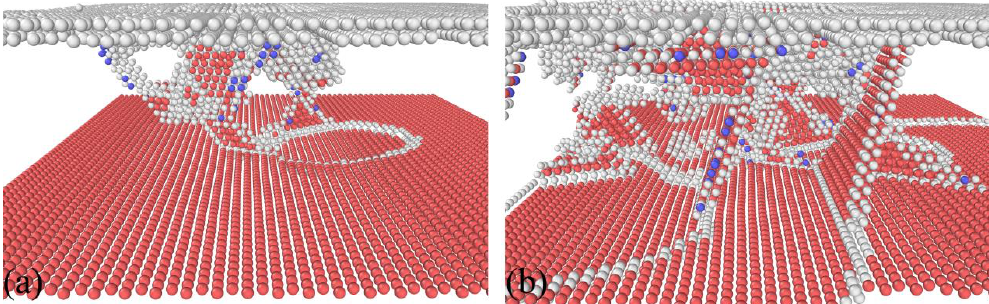
Figure 4. Representative dislocation–TB interactions. Displacement: ( a ) 0.88 nm; ( b ) 1.6 nm. Atoms are colored according to their CNA values, and perfect face-centered cubic (FCC) atoms are not shown.